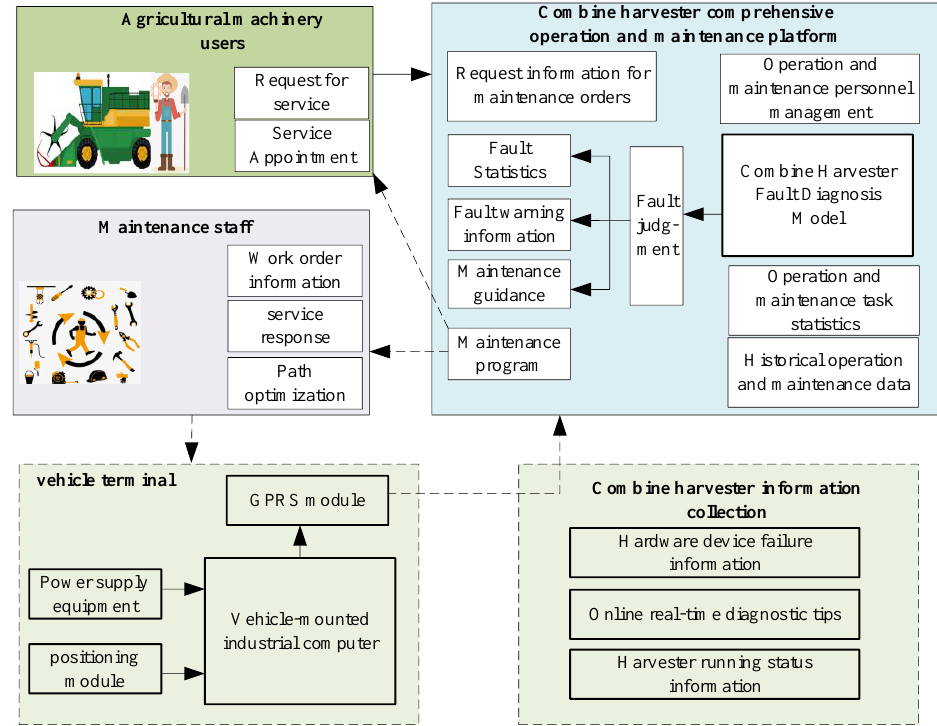
Figure 3. Overall operation and maintenance framework of combine